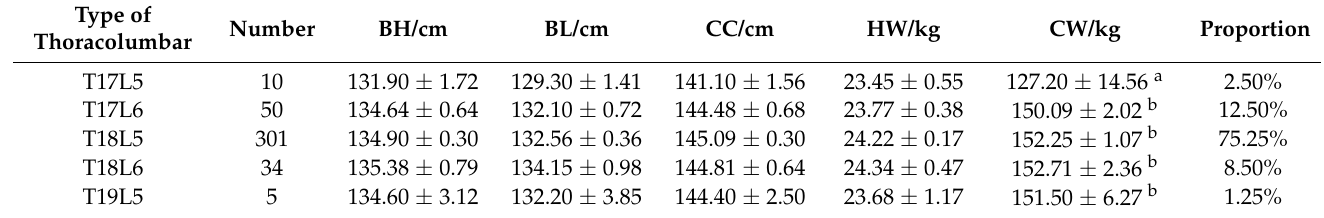
Table 5. Means with standard error of each phenotype for different thoracolumbar types of Dezhou